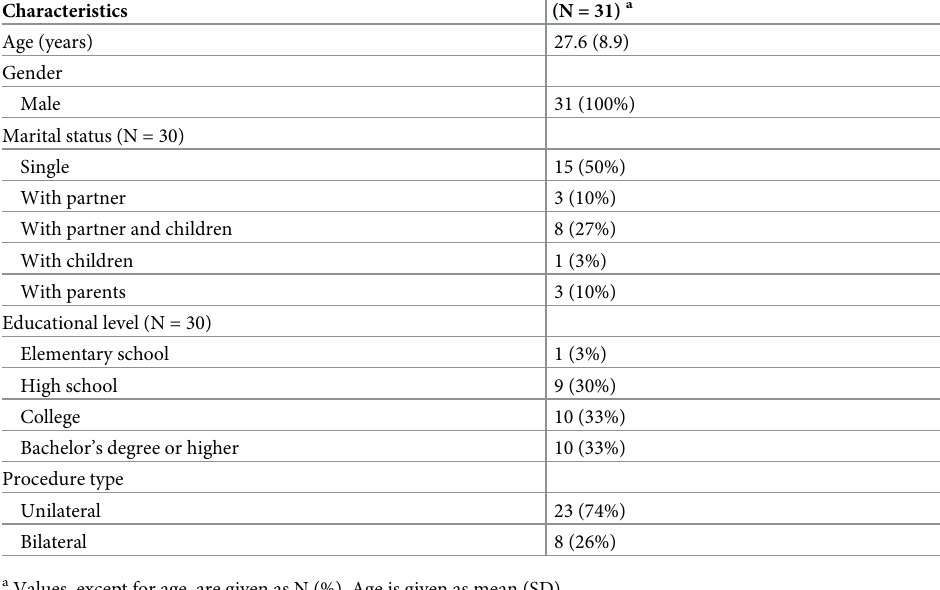
Table 1. Baseline characteristics of the patients who were operated with the totally extraperitoneal (TEP) endo- scopic inguinal hernia repair technique. Characteristics (N = 31) a